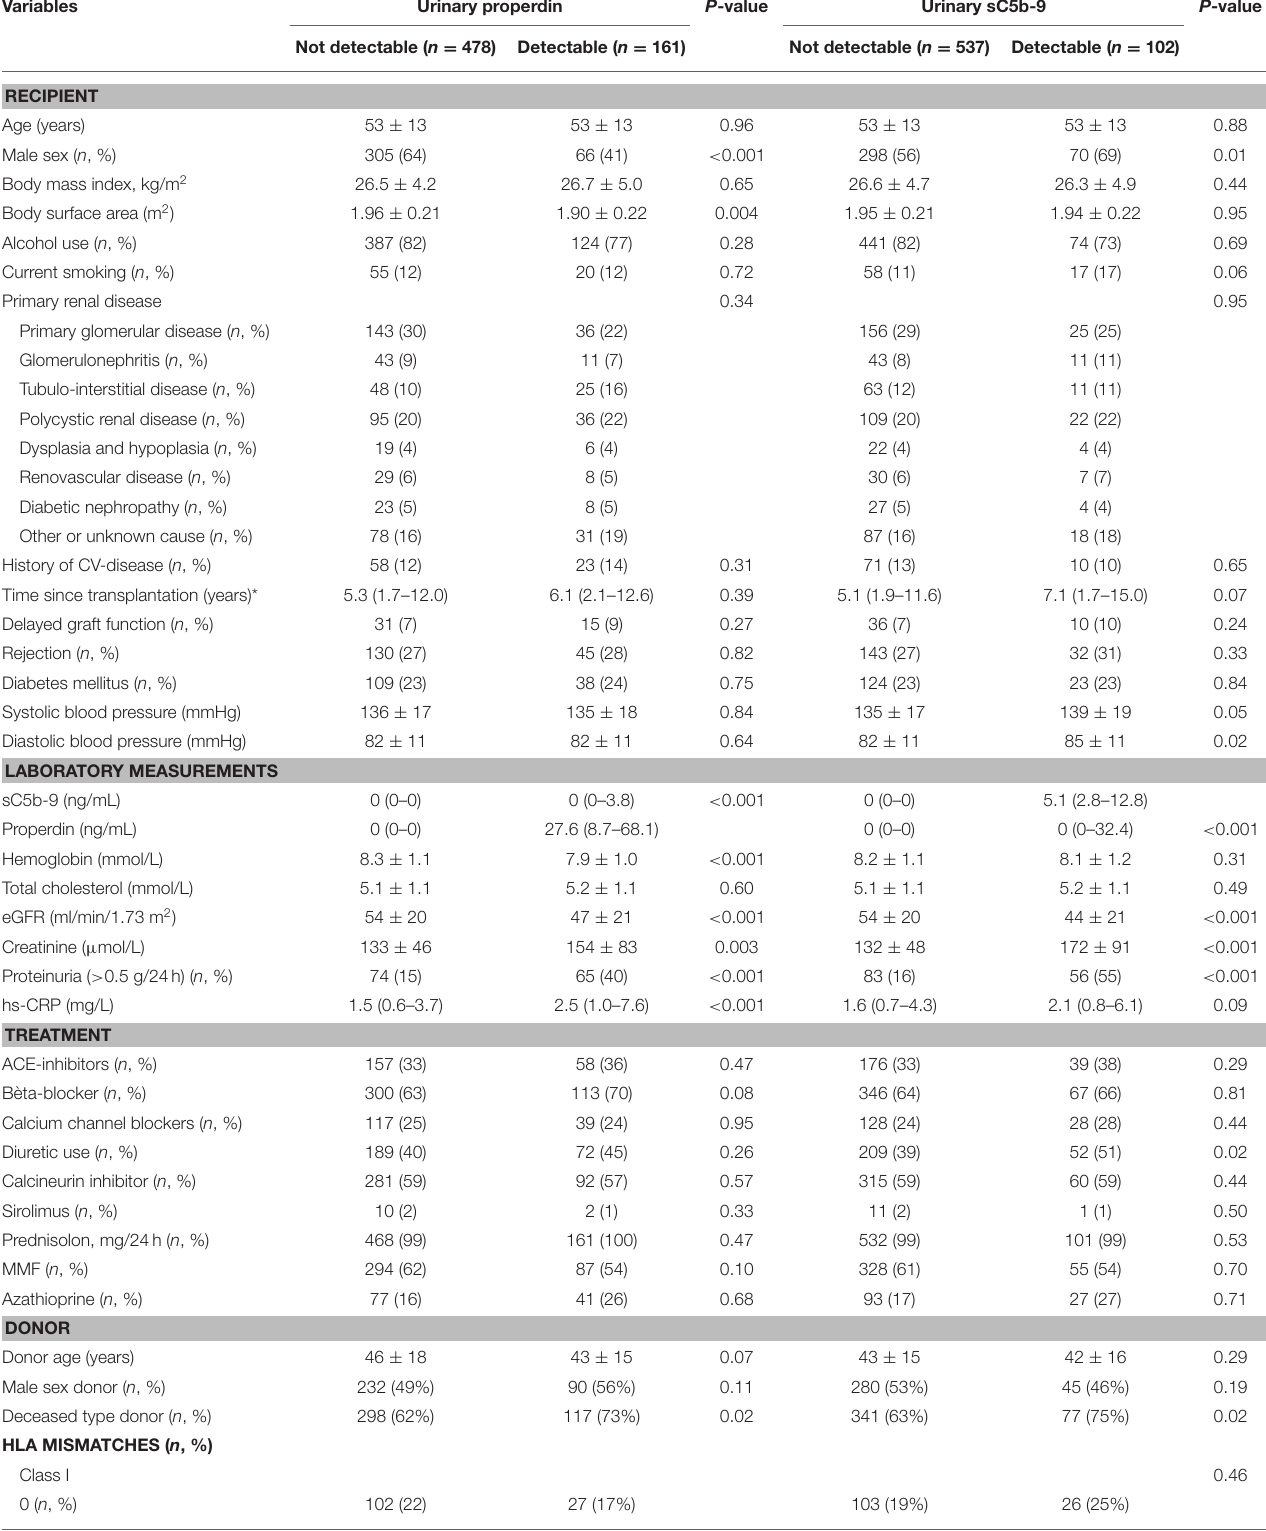
TABLE 1 | Baseline characteristics according to detectable urinary properdin urinary sC5b-9 levels.